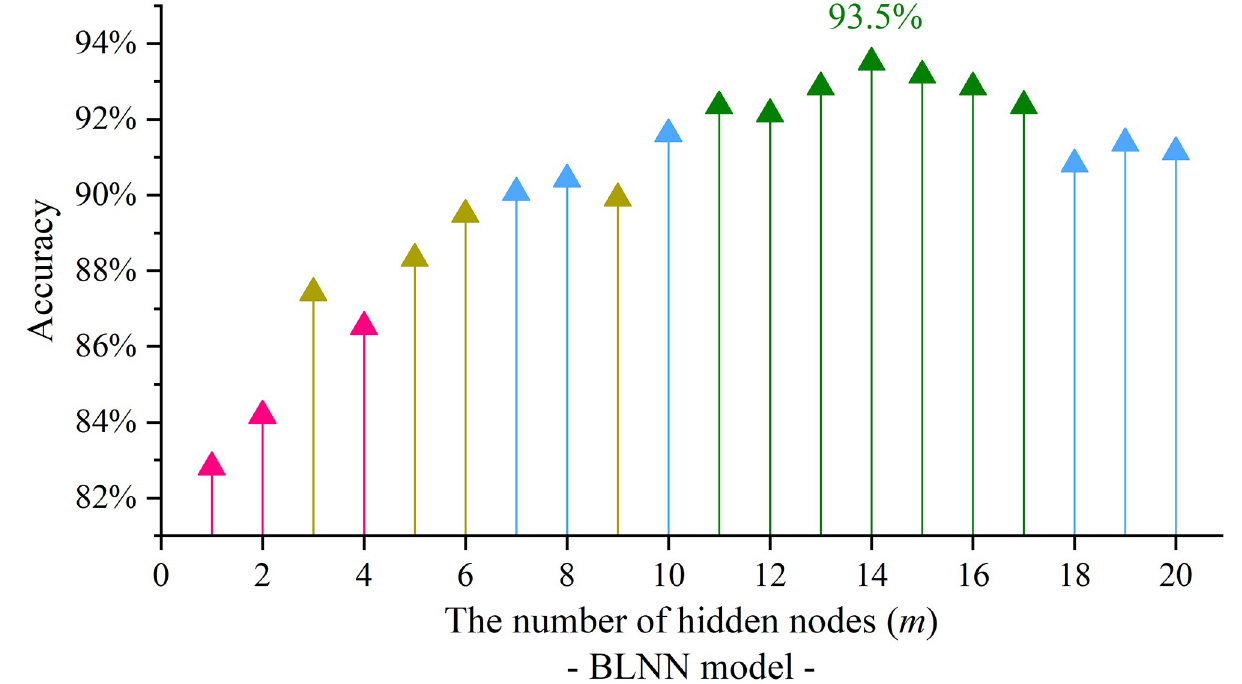
Fig 7. The tuning of the number of hidden neuron nodes for BLNN